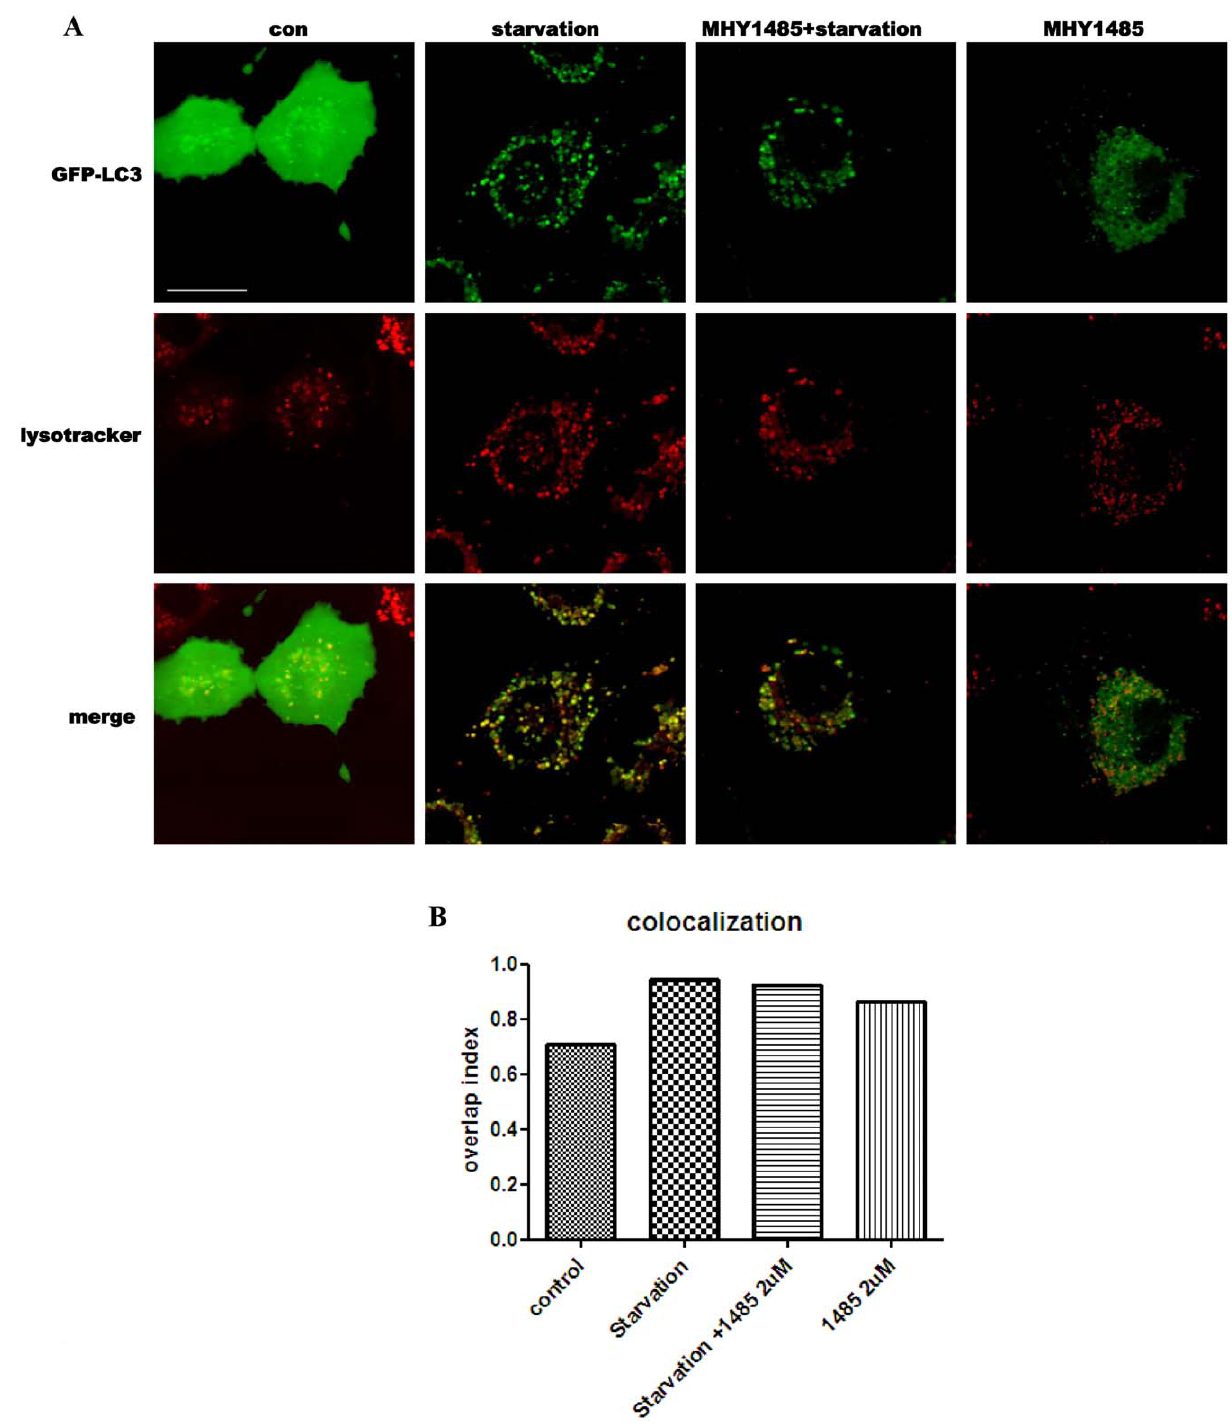
Figure 5. MHY1485 inhibition of starvation-induced colocalization between autophagosomes and lysosomes. Live-cell confocal microscopic images of AdGFP-LC3 (green) and lysosomes (red) stained by LysoTracker were collected from Ac2F cells under starvation or co- treatment of 2 m M MHY1485 for 6 h. Merged images show the co-localization of LC3-positive autophagosomes and lysosomes (yellow). Scale bar, 20 um. Bars represent the level of overlap index.